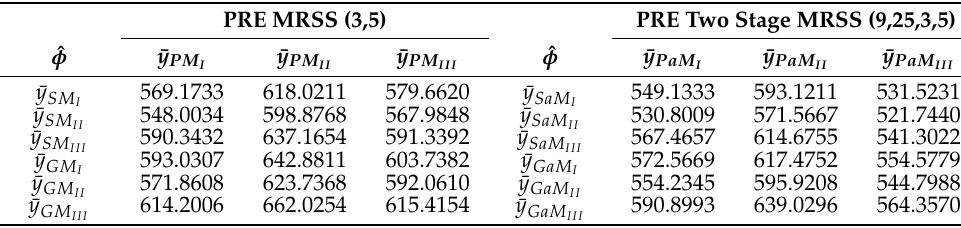
Table 11. PRE values for BMI data for odd sample size.